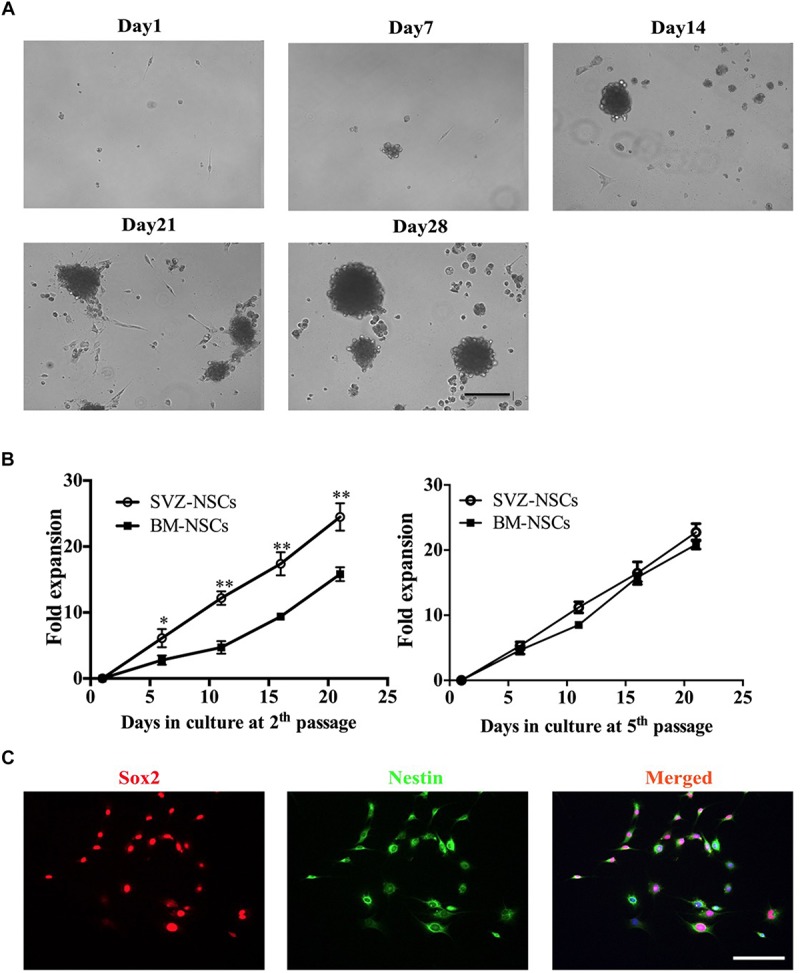
Generation of bone marrow-derived NSCs in vitro. BM-NSCs were isolated and expanded from bone marrow of adult C57BL/6 mice and cultured in DMEM/F12 containing 20 ng/ml EGF, 20 ng/ml Bfgf, and 2% B27 supplements. (A) Single cells were seeded in poly-D-lysine- and laminin-coated plates. After 7 days, the cells showed obvious proliferation. After 14 days, the NSCs gradually formed neurospheres. After 21–28 days, neurospheres increased size, and detached from the bottom of the culture plate. (B) Growth curves of BM-NSCs and SVZ-NSCs. Single cells at the second and fifth passages were seeded at a density of 1.0 × 105 cells/ml and cultured in proliferation media. At days 6, 11, 16 and 21, neurospheres in each well were digested into single cells; cell numbers were counted by hemocytometer. At least 5 wells were evaluated at each time point. Data represent the mean ± SD from three repeated experiments from separately generated cultures, ∗p < 0.05, ∗∗p < 0.01, as determined by two-way ANOVA with Tukey’s multiple comparison test. (C) Neurospheres dissociated with accutase and plated in the coated coverslips were immunostained for NSC markers Sox2 and Nestin. Scale bar = 50 μm.